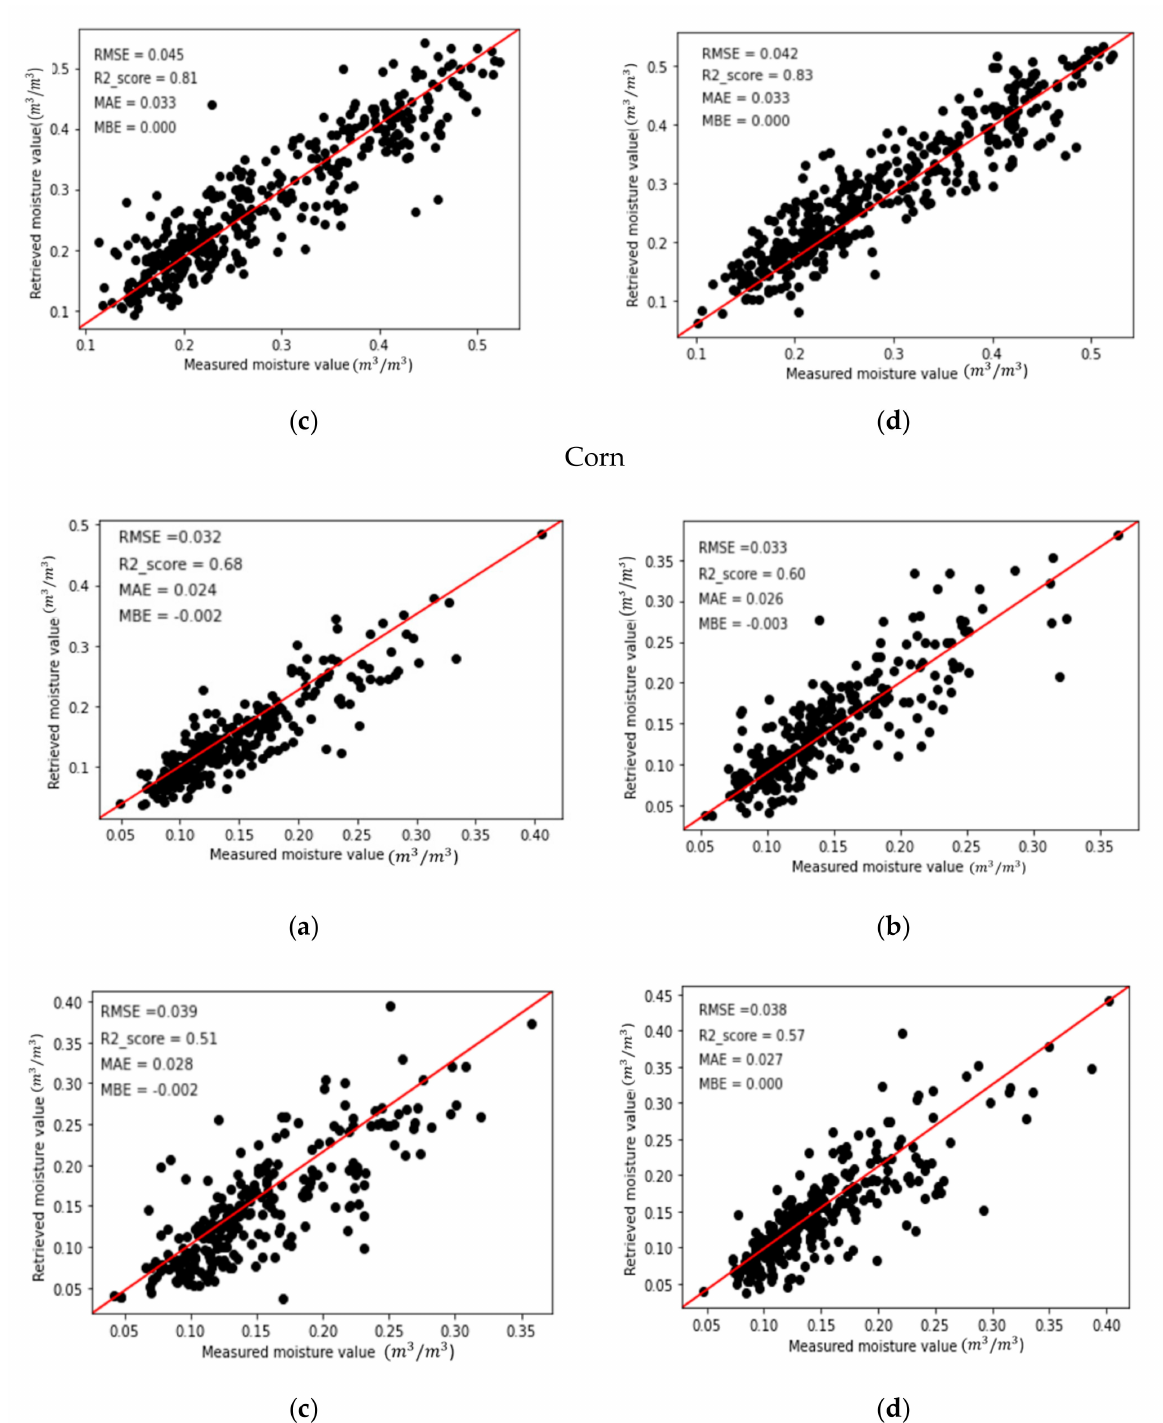
Figure 4. Soil moisture retrieved using a random forest (RF) algorithm plotted against field-measured soil moisture. Four plots are provided for each crop type (soybeans, wheat, and corn). For each crop type, soil moisture retrieval results are provided based on ( a ) all extracted features, and also using features selected by ( b ) trial and error, ( c ) forward feature selection (FFS), and ( d ) backward feature selection (BFS) selection